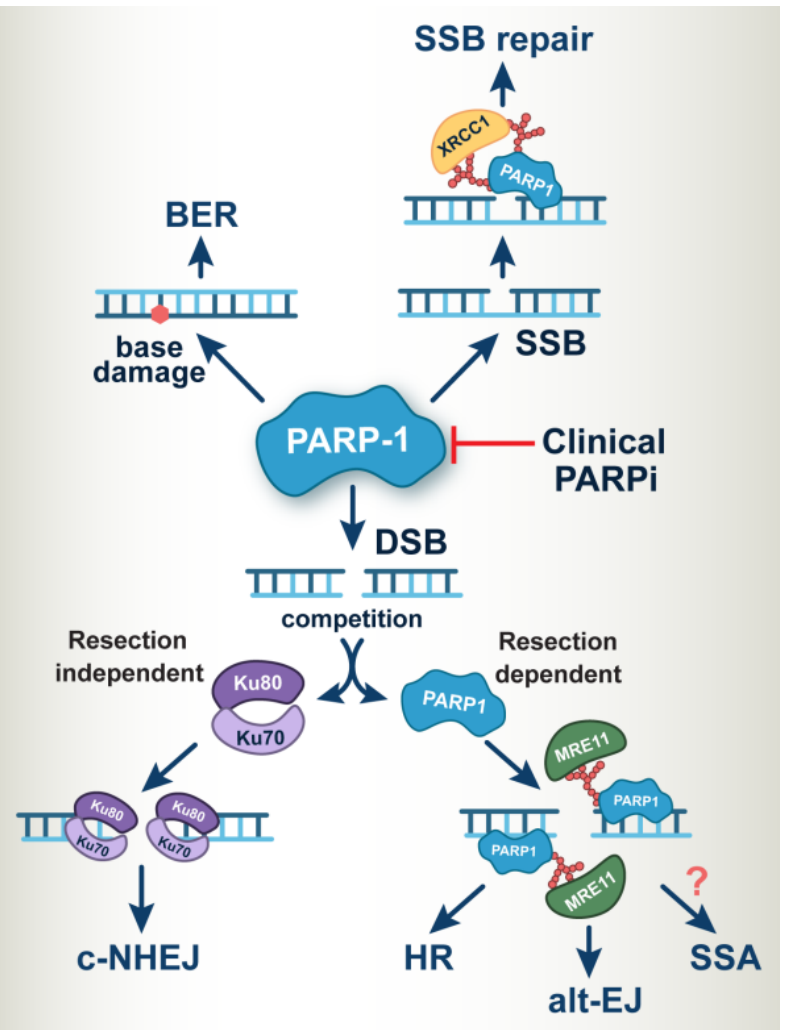
Figure 2. A central and critical role of PARP-1 in DNA repair. PARP-1 is the prime target of clinical PARPi and mediates multiple DNA repair processes (Please refer to Section 2 for details).